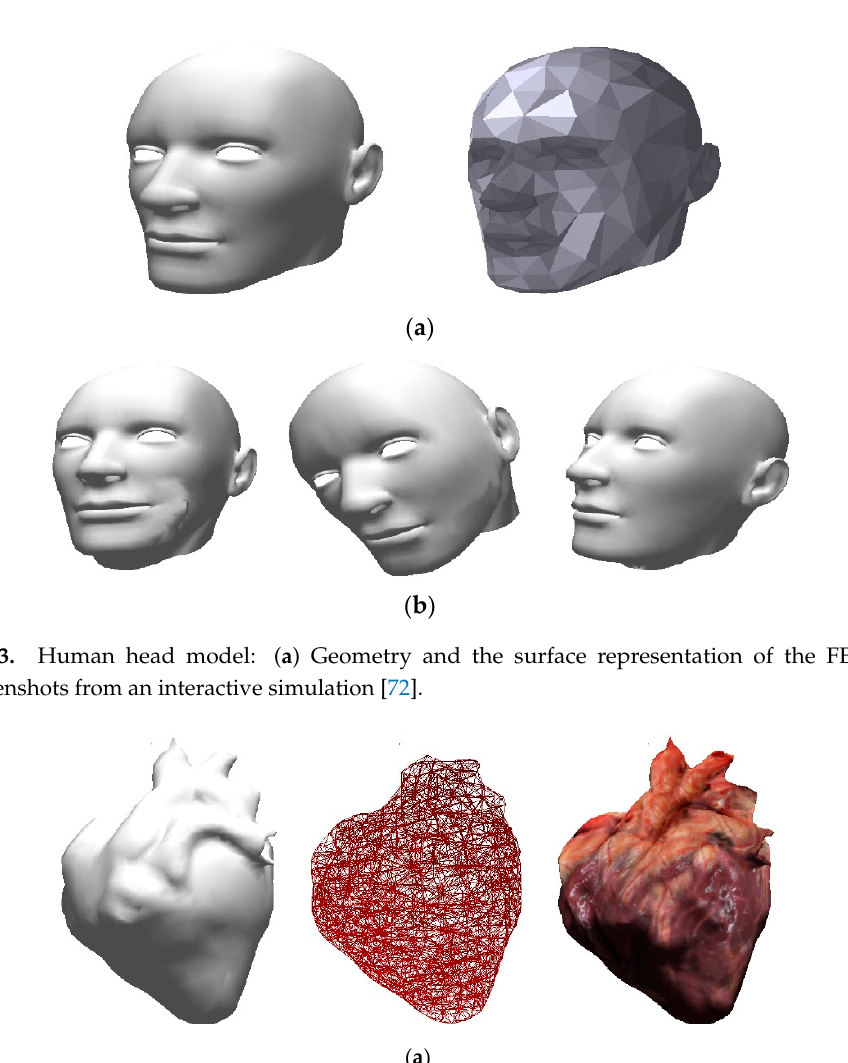
( b ) Figure 5. Dog model: ( a ) Geometry, FE mesh, and texture; ( b ) screenshots from an interactive simulation [7]. 7. Conclusions FEM-based real-time simulation has entered numerous fields ranging from entertainment to engineering. Although we are witnessing the early days of its development, an immense amount of work has already been done to respond to the challenges of performing real-time simulations using currently available computer hardware technology. This paper aimed at a not exhaustive but representative survey of the development in the field. It would certainly take a prohibitively large space to mention all or most of the work done and, hence, the objective was to represent different